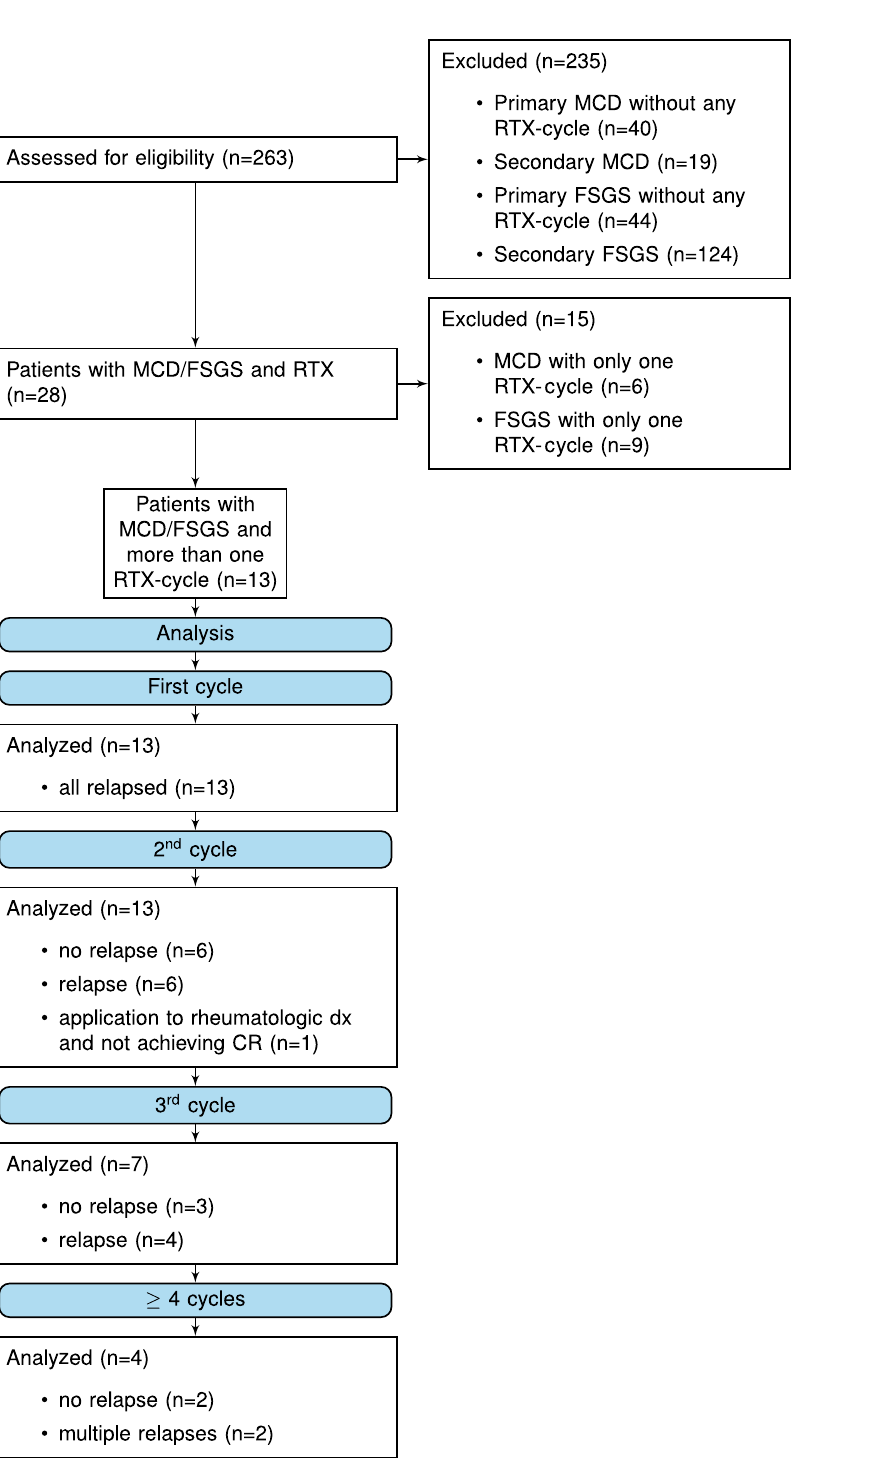
Figure 1. Consort flow